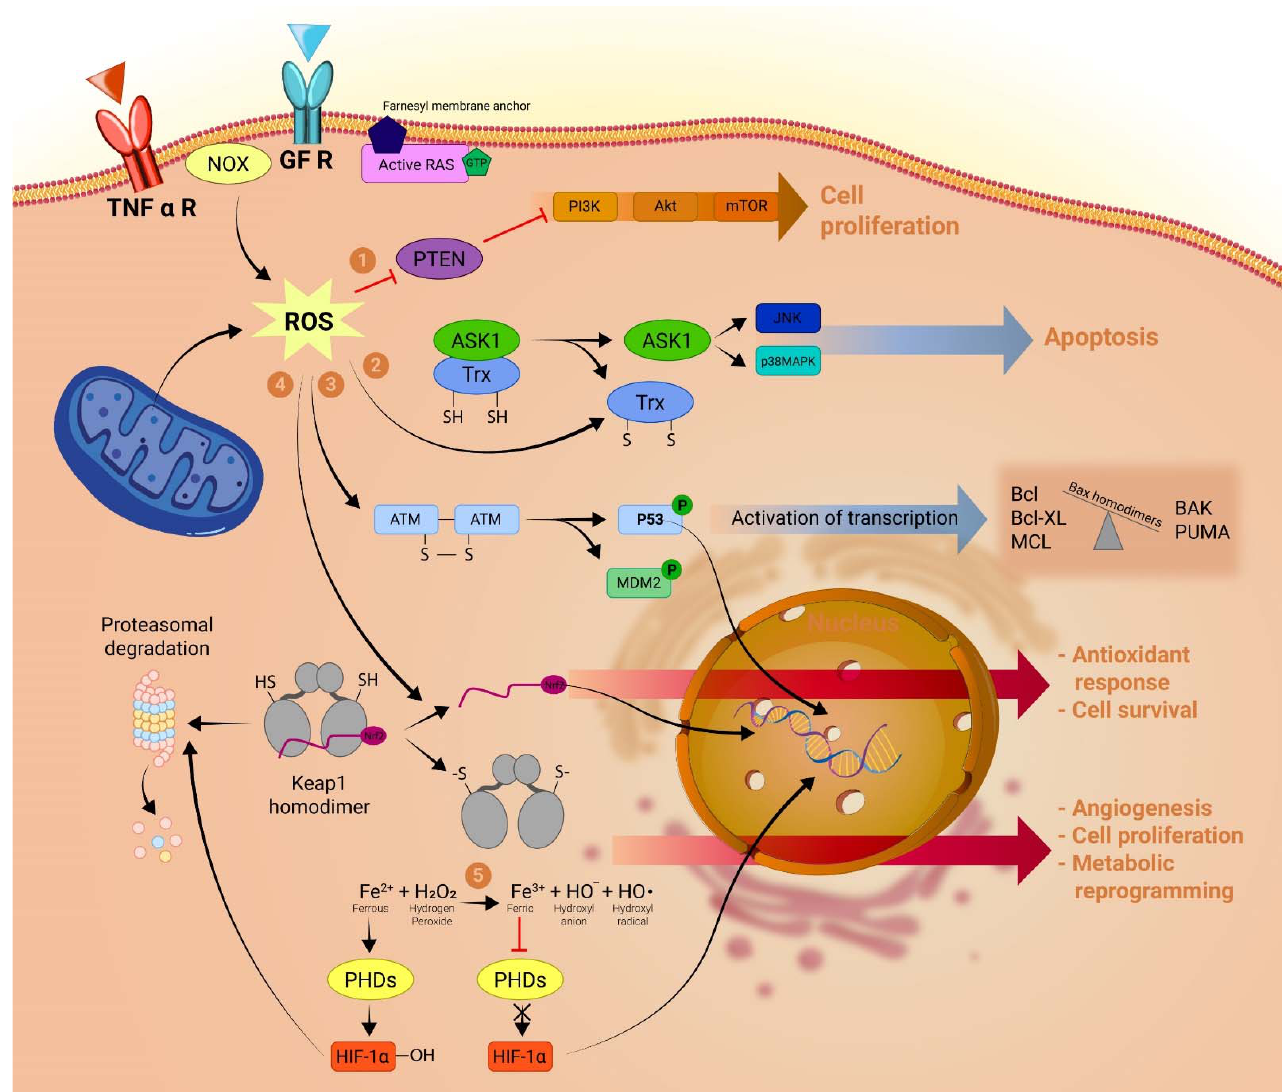
Figure 1. ROS functions in cancer cells: The production of ROS is elevated in tumor cells as a conse- quence of increased metabolic rate, gene mutation, extracellular growth factor signaling and relative hypoxia. This increase in the baseline ROS level plays a crucial role in determining cancer cells’ fate: (1) ROS can drive cancer cell proliferation by inactivating PTEN, a tumor suppressor that acts as a brake on the pro-growth PI3K/Akt pathway. (2) Inversely, increased ROS can have a nefarious effect on the cancer cell by activating apoptotic pathways. As such, oxidative stress may lead to the for- mation of disulfide bonds in the thioredoxin molecule, which results in the activation of the kinase Ask1 and subsequent activation of key apoptotic transcription factors like JNK and p38. (3) A similar process occurs in the case of p53 activation, where an ROS-triggered formation of disulfide bonds at the Cys 2999 residues of ATM homodimer results in activation and subsequent phosphorylation of p53 and its inhibitory molecule MDM2. P53 alongside JNK, p38, and other transcription factors will shift the balance towards apoptosis by expressing proteins, such as Bax homodimers, BAK and PUMA, to the detriment of antiapoptotic proteins such as Bcl-2, Bcl-XL or MCL. (4) ROS can prevent the proteasomal degradation of transcription factor Nrf2 by dissociating the KEAP1-Nrf2 complex and thus allowing Nrf2 to translocate to the nucleus and activate antioxidant pathways that can mitigate the proapoptotic effect of ROS. (5) By oxidizing iron from its ferrous (Fe 2+ ) to its ferric (Fe 3+ ) state, ROS dampens the enzymatic activity of PHDs which would normally hydroxylase the HIF- 1 α protein causing its proteasomal degradation. The non-hydroxylated form of HIF-1 α has a major role in promoting cancer cell survival, angiogenesis and metabolic reprogramming under hypoxic conditions. PTEN, phosphatase and tensin homolog; Ask1, apoptosis signal-regulating kinase 1;